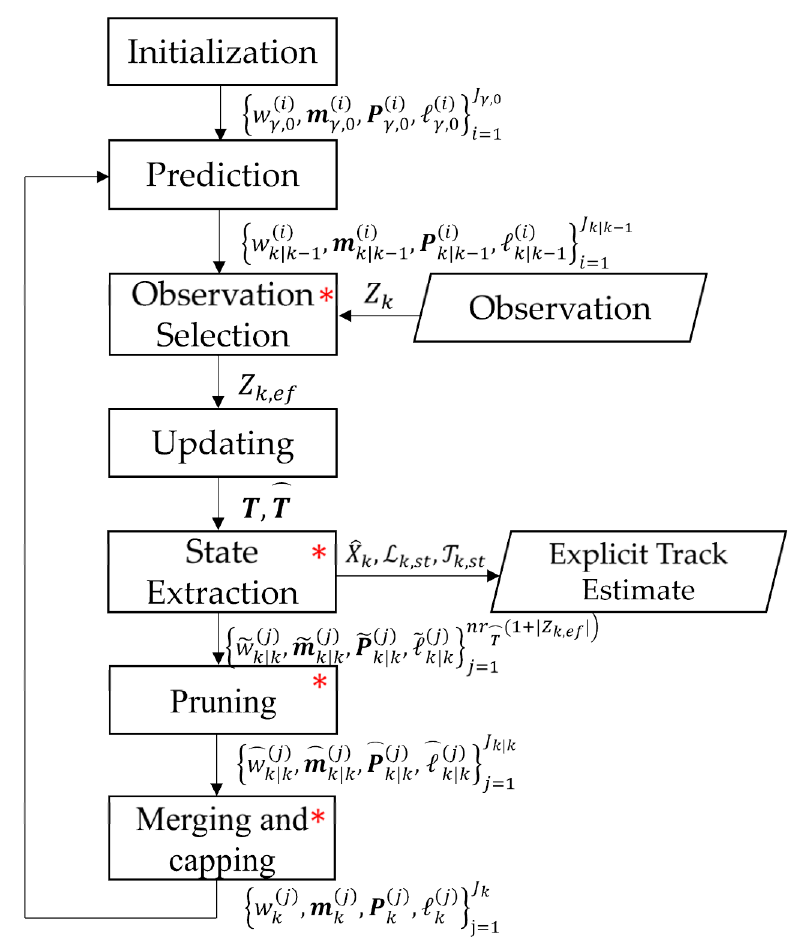
Figure 3. Overall procedure of the LGM-PHD